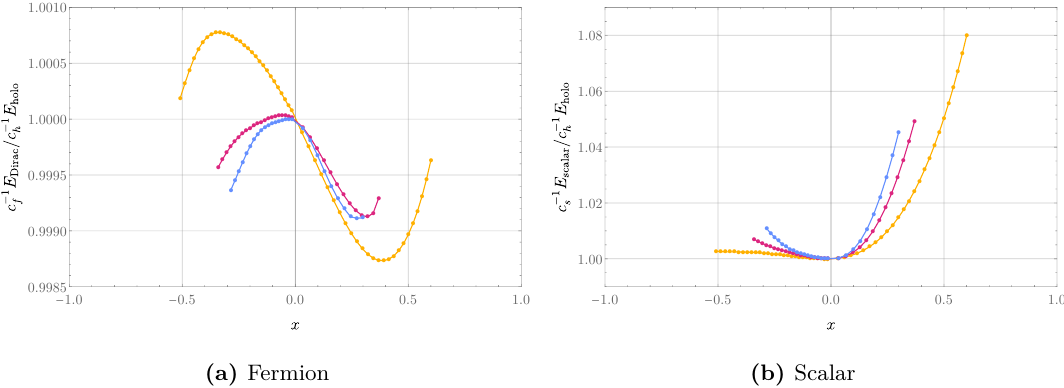
Figure 6 . The ratio between the Casimir energy of the holographic CFT and the free fields on the geometries (2.5); orange, magenta, and blue correspond to l = 2 , 4 , and 6, respectively. Note that the variation between the Dirac fermion and the holographic CFT is less than ∼ 0 . 1 % for all the deformations shown here, while the variation between the scalar and the holographic CFT reaches up to ∼ 8 %.